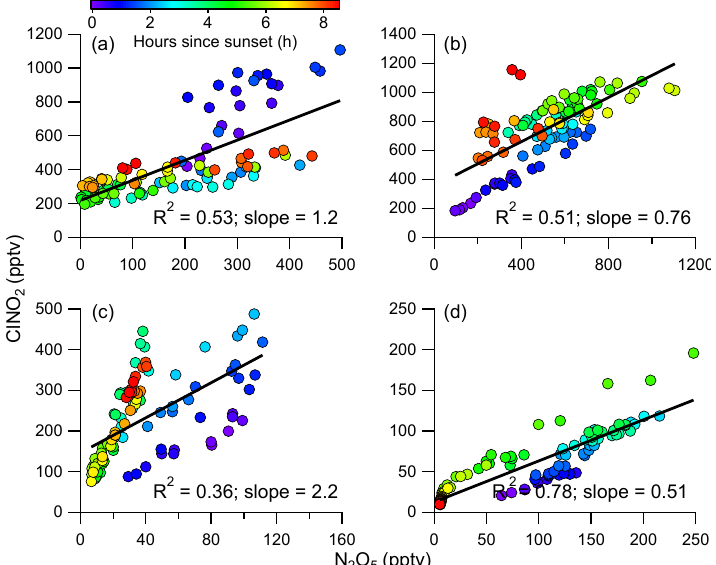
Figure 4. Correlations between ClNO 2 and N 2 O 5 for four different nights, i.e., P1, P2, P3, and P4. The data are color coded by the hours since sunset. Also shown are the correlation coefficients and slopes.